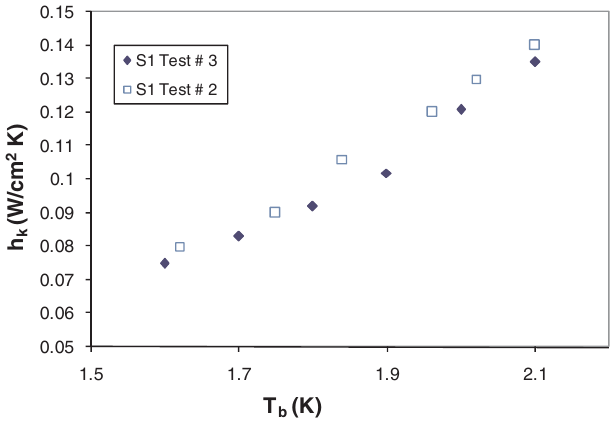
FIG. 13. (Color) Kapitza conductance measurements of the sam- ple S1 before and after the plastic deformations reveal no significant difference.